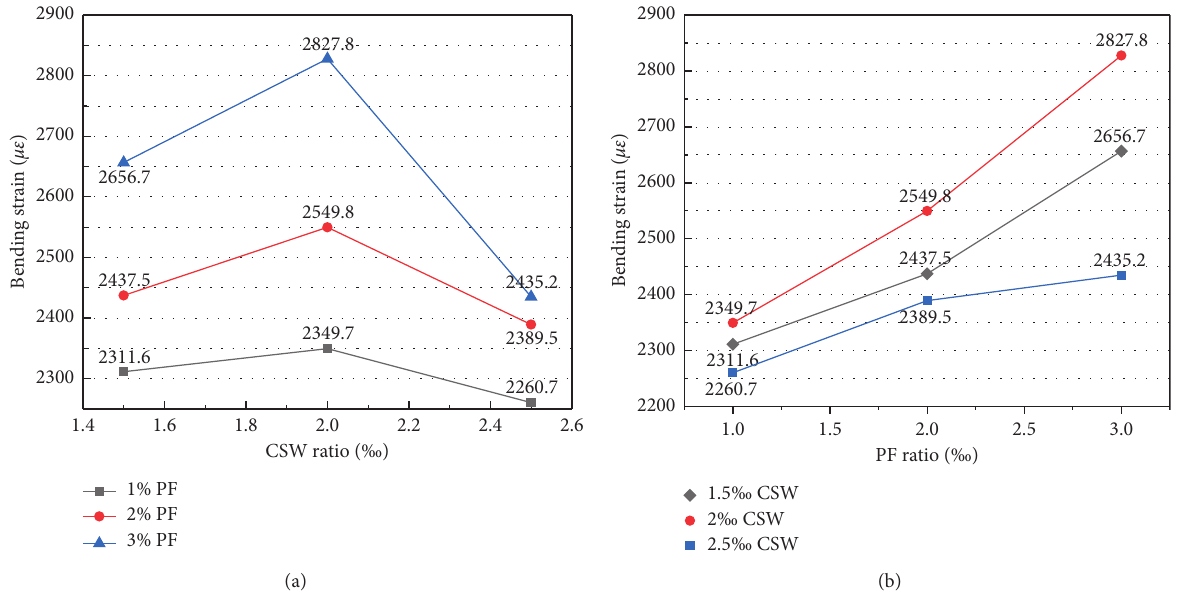
Figure 3: Bending test results. (a) Comparison of bending strain values for different calcium sulfate whisker rates and for certain polyester fiber amounts. (b) Comparison of bending strain values for different polyester fiber amounts and for certain calcium sulfate whisker